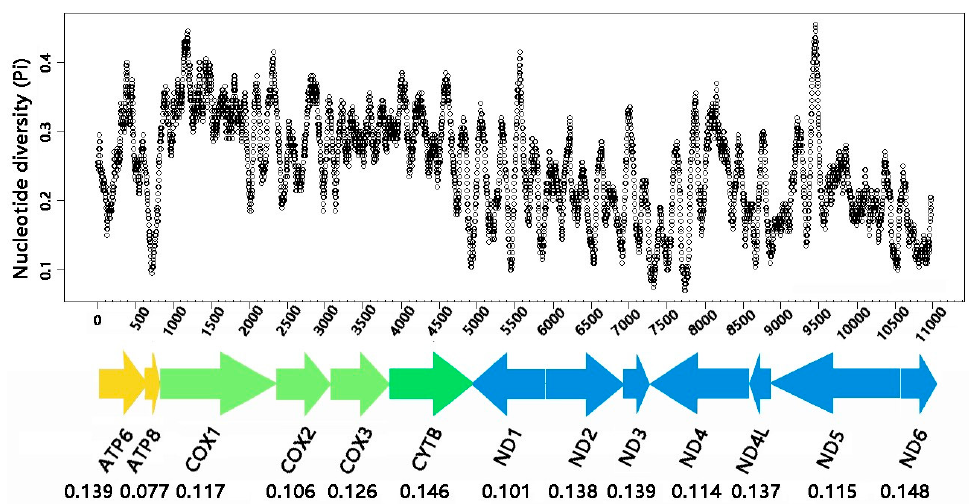
Figure 3. The nucleotide diversity (Pi) of 13 aligned PCGs of mt genomes among H. thoracica and H. yehi in a sliding window analysis (a sliding window of 150 bp with the step size of 5 bp). The line of small circles showed the value of Pi. Each gene names and the Pi values were shown in the graph. The analysis of pairwise genetic distance showed differing results, with ND6 (0.186), CYTB (0.184), and ND3 (0.173) having evolved relatively fast, and ATP8 (0.088) and ND1 (0.117) evolving slower (Figure 4).